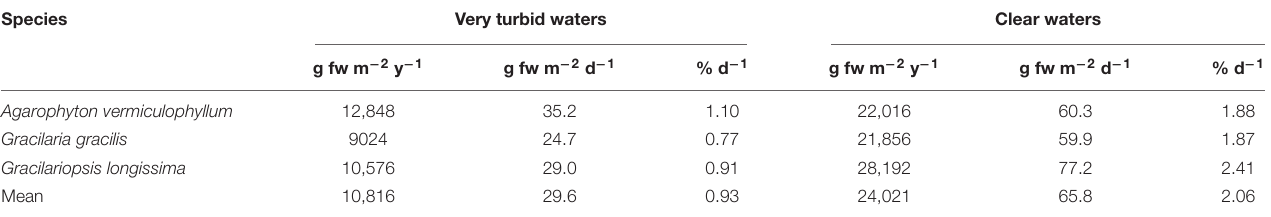
TABLE 2 | In field annual net production and growth rate of some macroalgae in the Venice Lagoon. Species